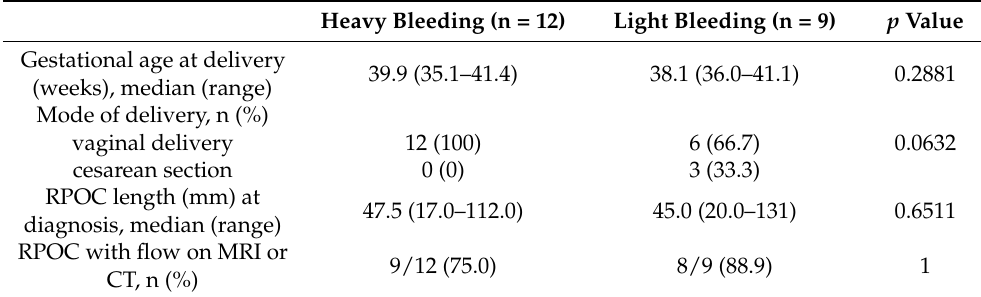
Table 1. Univariate analysis between RPOC with heavy bleeding and light bleeding during conserva- tive management. RPOC: retained products of conception. Heavy Bleeding (n = 12) Light Bleeding (n = 9) p